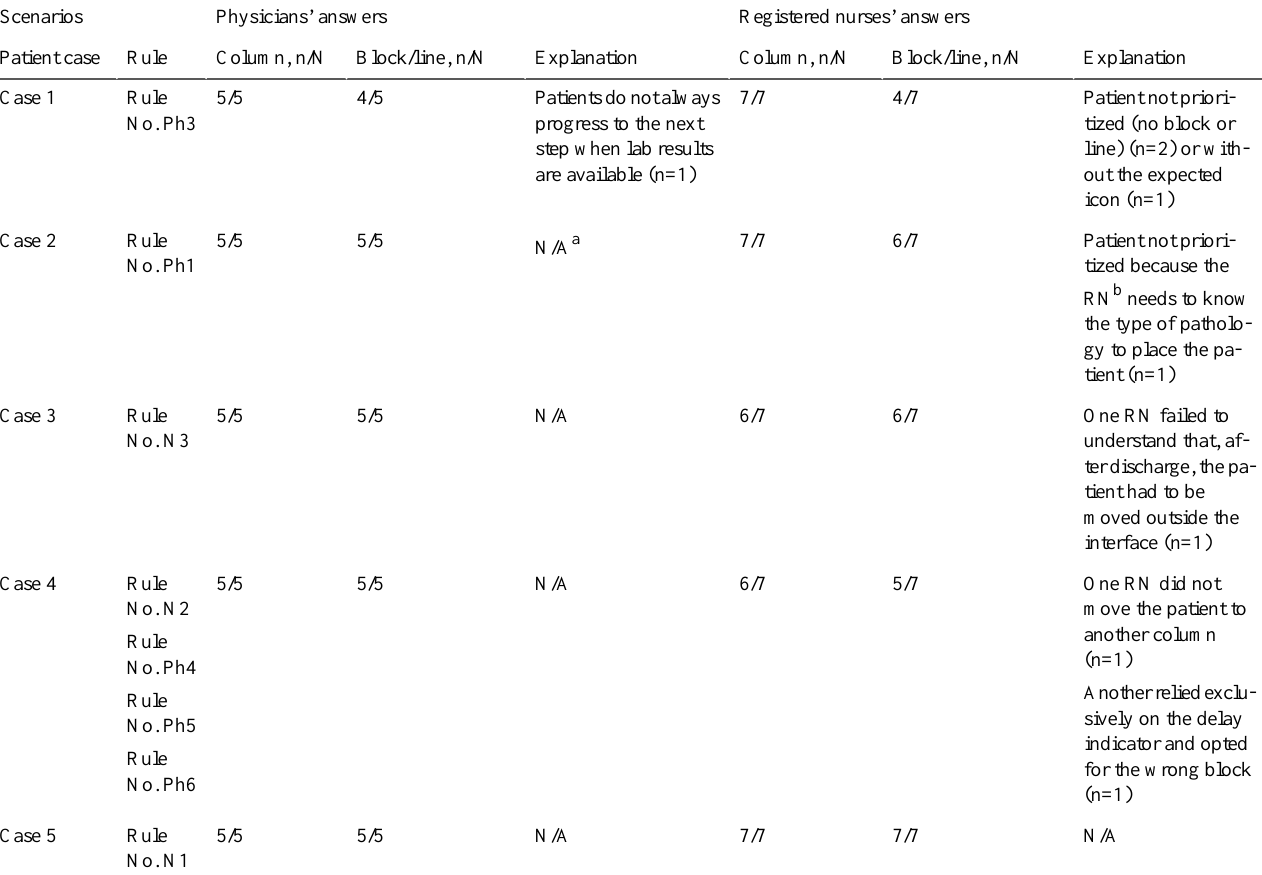
Table 3. Results of phase 3 of the user testing: proportion of correct prediction according to the patient case and the profile of the participant, along with explanations in case of erroneous